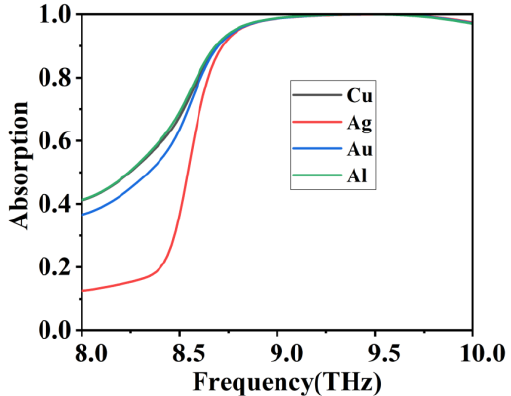
Figure 7. Absorption simulation curves of different materials.